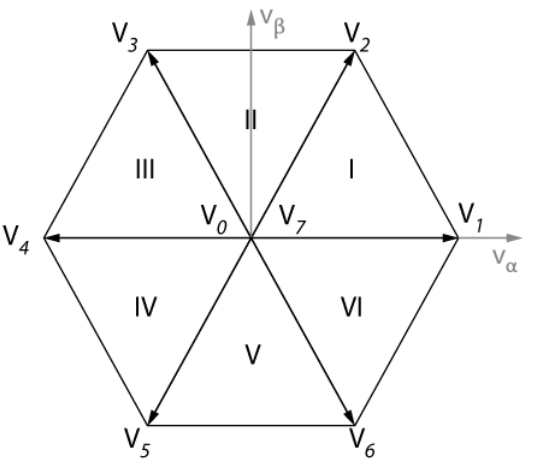
Figure 12. Representation of the active and zero space vectors in the αβ plane, and its division in the modulation sectors (numbered by Roman